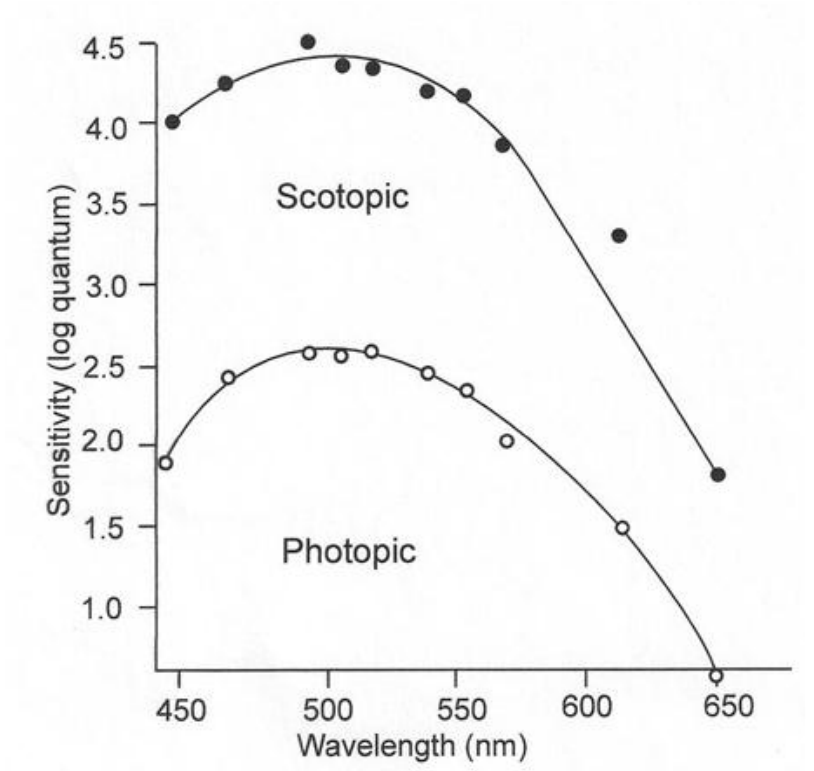
Figure 3. Juvenile lemon shark’s visual sensitivities under low light (scotopic) and high light conditions, based on the response of a single shark [12].